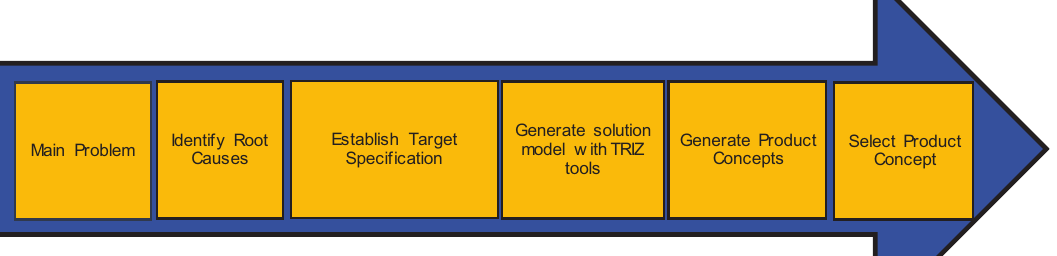
Figure 1. Research methodology flow